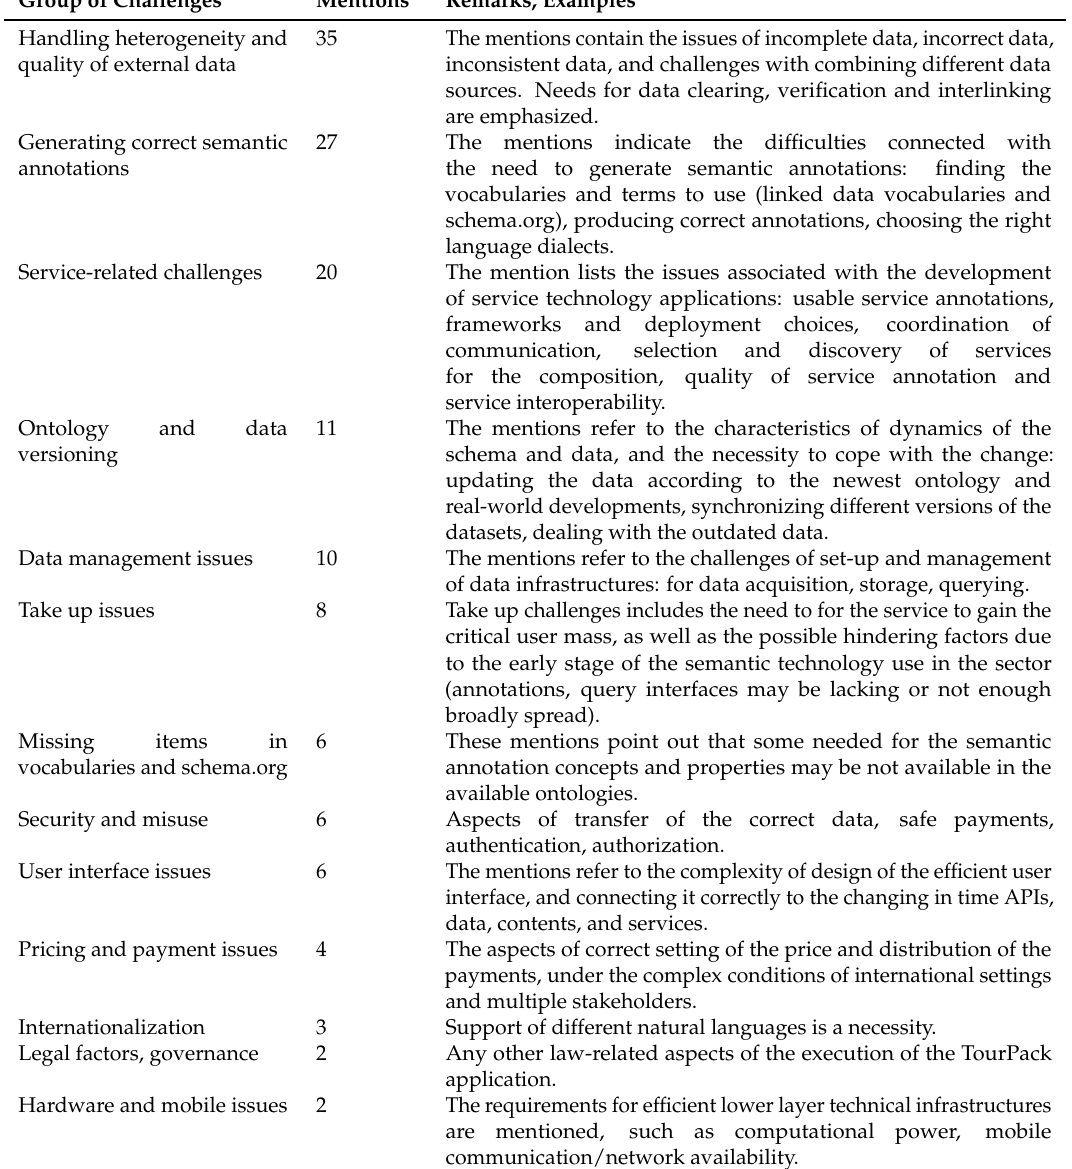
Table 2. Commonly identified challenges and their reported